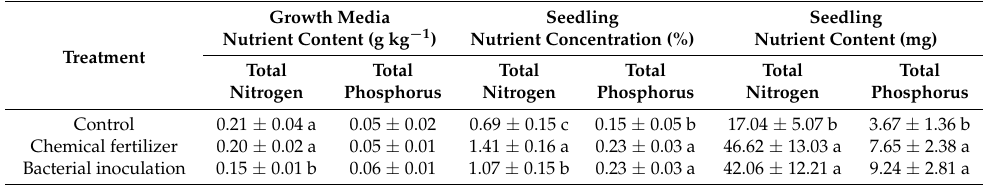
Table 1. Total nitrogen and total phosphorus contents of growth media and concentrations and contents of total nitrogen and total phosphorus in coastal pine seedlings for the control, chemical fertilizer, and inoculation with B. licheniformis MH48 treatments.